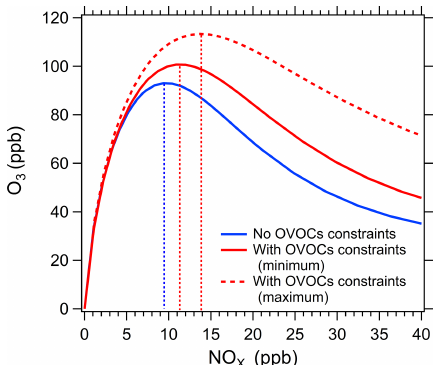
Figure 4. Model simulated dependence of daily peak O 3 concen- trations on NO x concentrations without (blue curve) and with (red curves) all observed photodegradable OVOCs constrained . The red solid and red dashed curves represent the scenarios with minimum and maximum OVOC contributions to P (RO x ), respectively. The dashed lines parallel to y -axis represent the threshold of NO x levels to distinguish between VOC-limited and NO x -limited